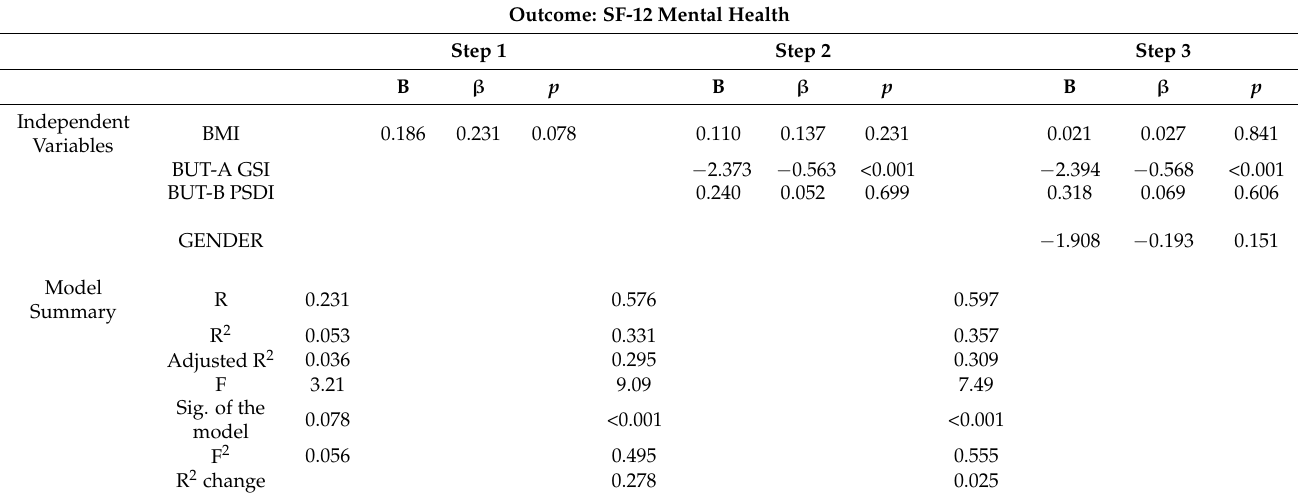
Table 6. Fourth hierarchical regression models including three steps, with BMI as predictor in first step; BMI, BUT-A GSI, and BUT-B PSDI as predictors in second step; BMI, BUT-A GSI, BUT-B PSDI, and gender as predictors of SF-12 Mental Health in third step.